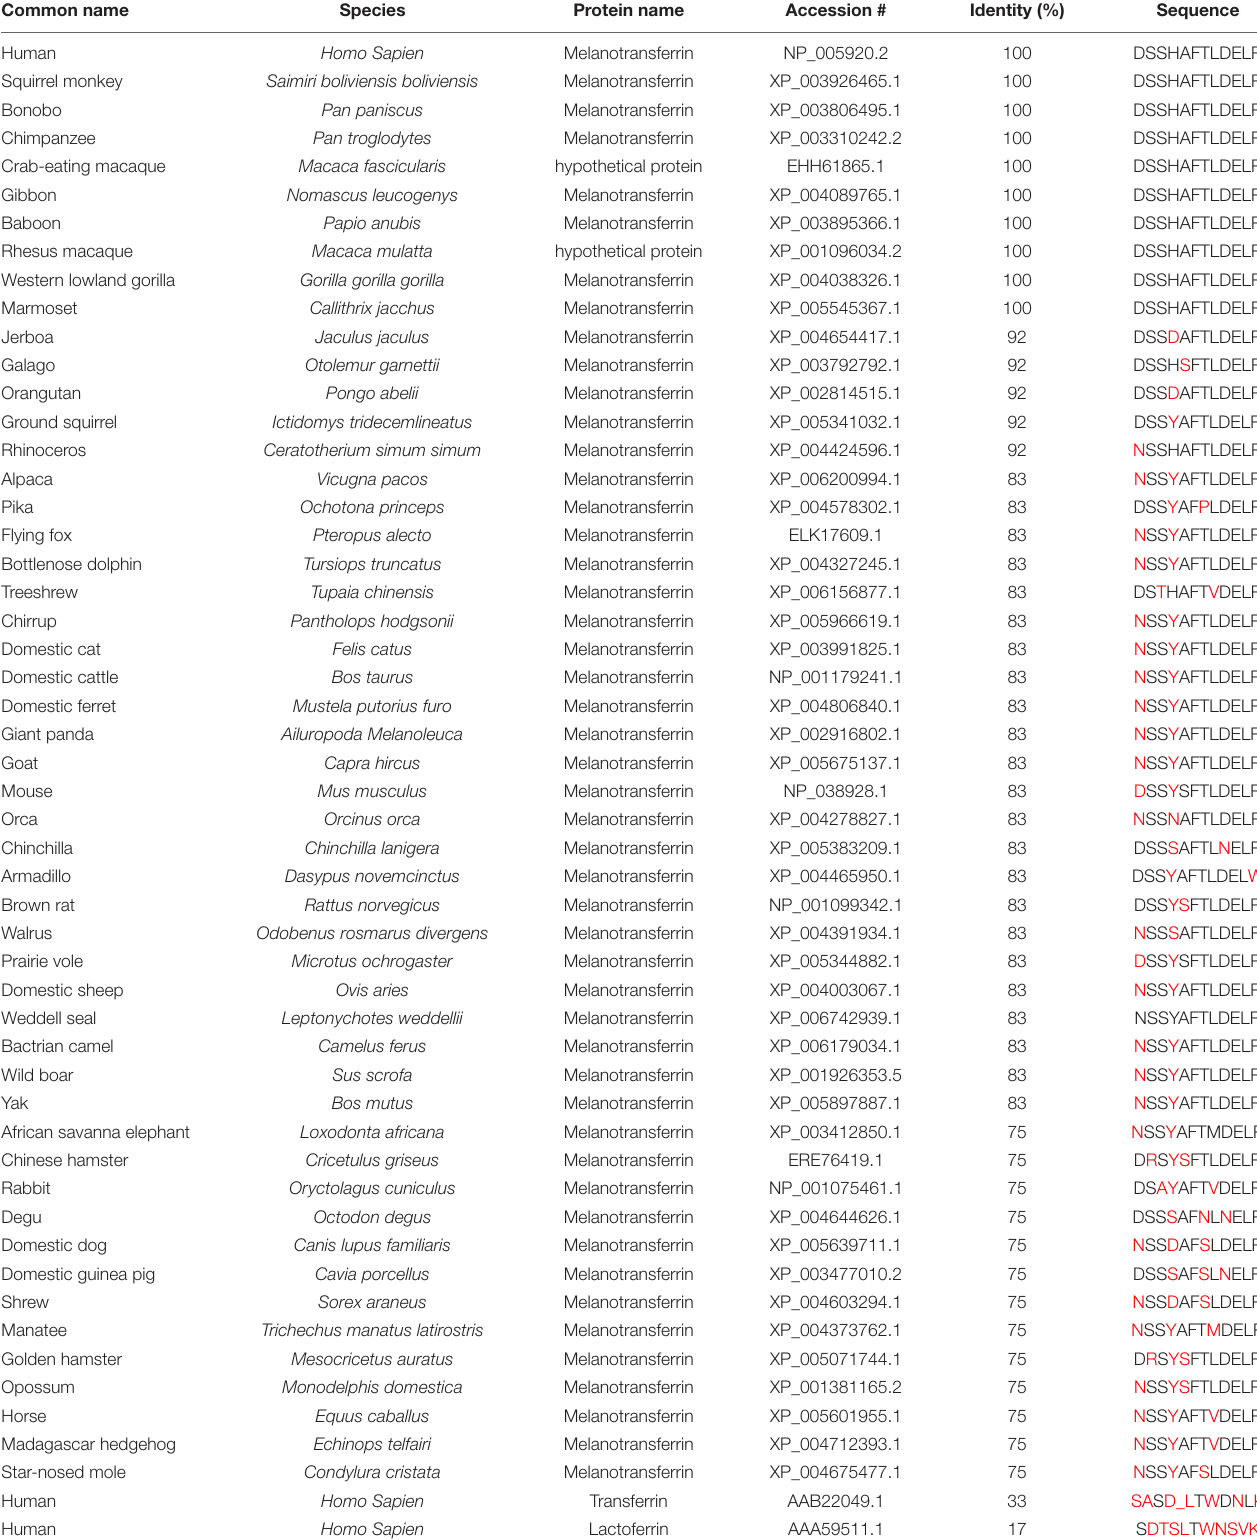
TABLE 3 | Phylogenetic comparisons of MTfp